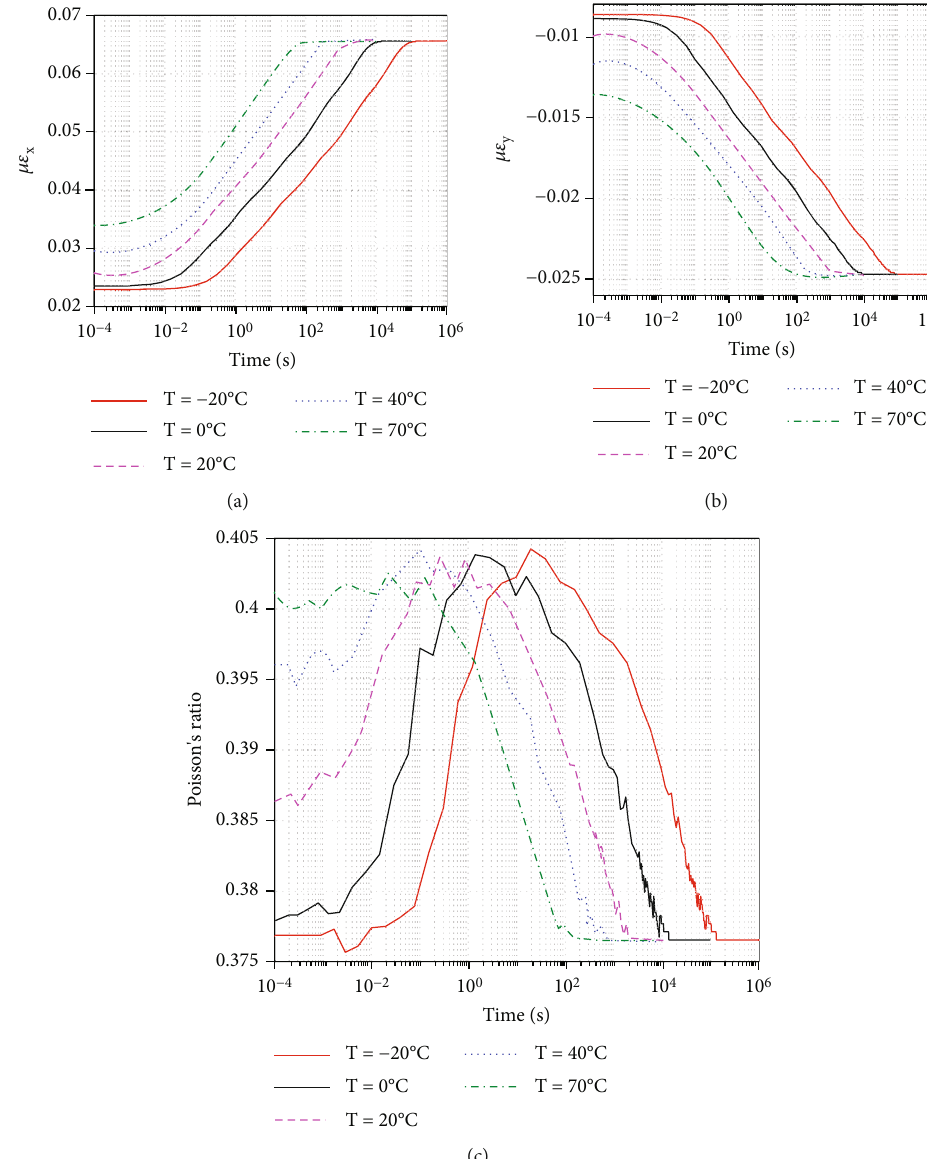
Figure 17: The curves of (a) longitudinal strain, (b) transverse strain, and (c) Poisson ’ s ratio versus time under di ff erent loading temperatures when cohesive strength equals to